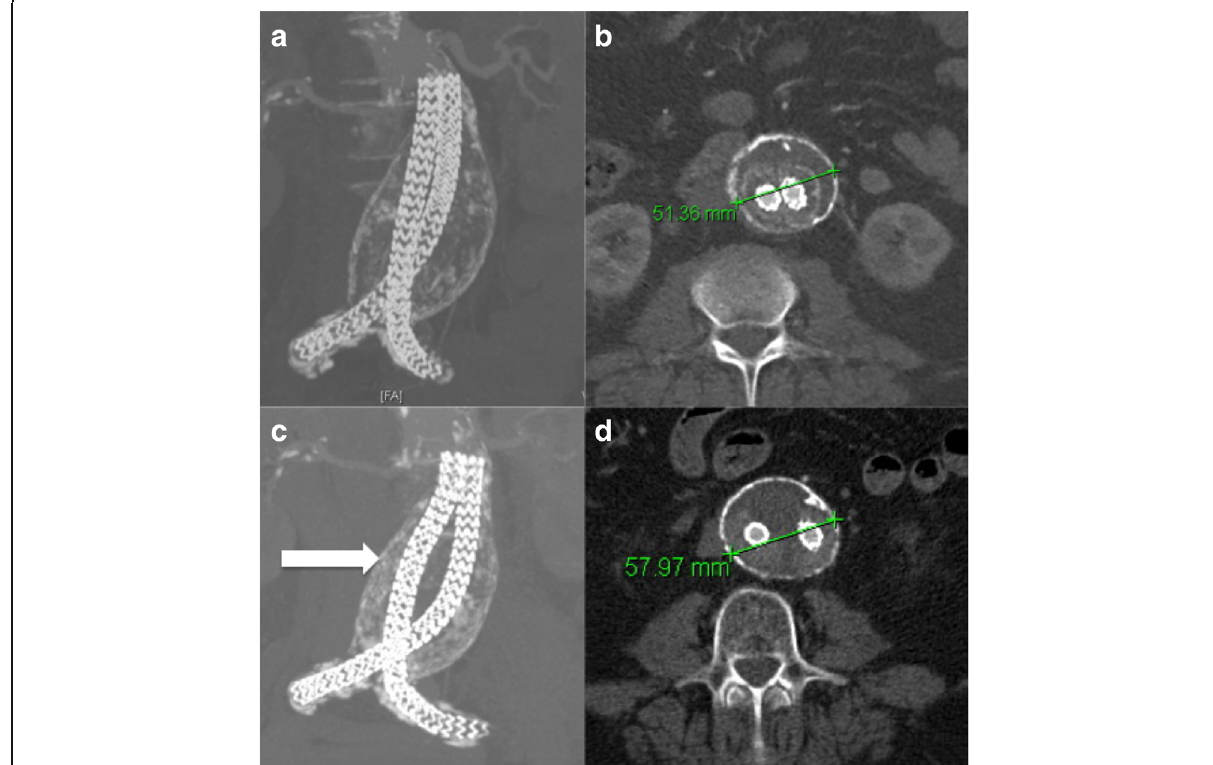
Fig. 3 a Coronary reconstruction of a CT scan showing the satisfactory deployment of a Nellix device with lack of separation of the grafts. b Transverse CT scan confirming the sac size after deployment. c , d Follow-up CT 2 years later shows separation of the grafts and sac expansion. This is a result of a subtle type Ia endoleak between the two